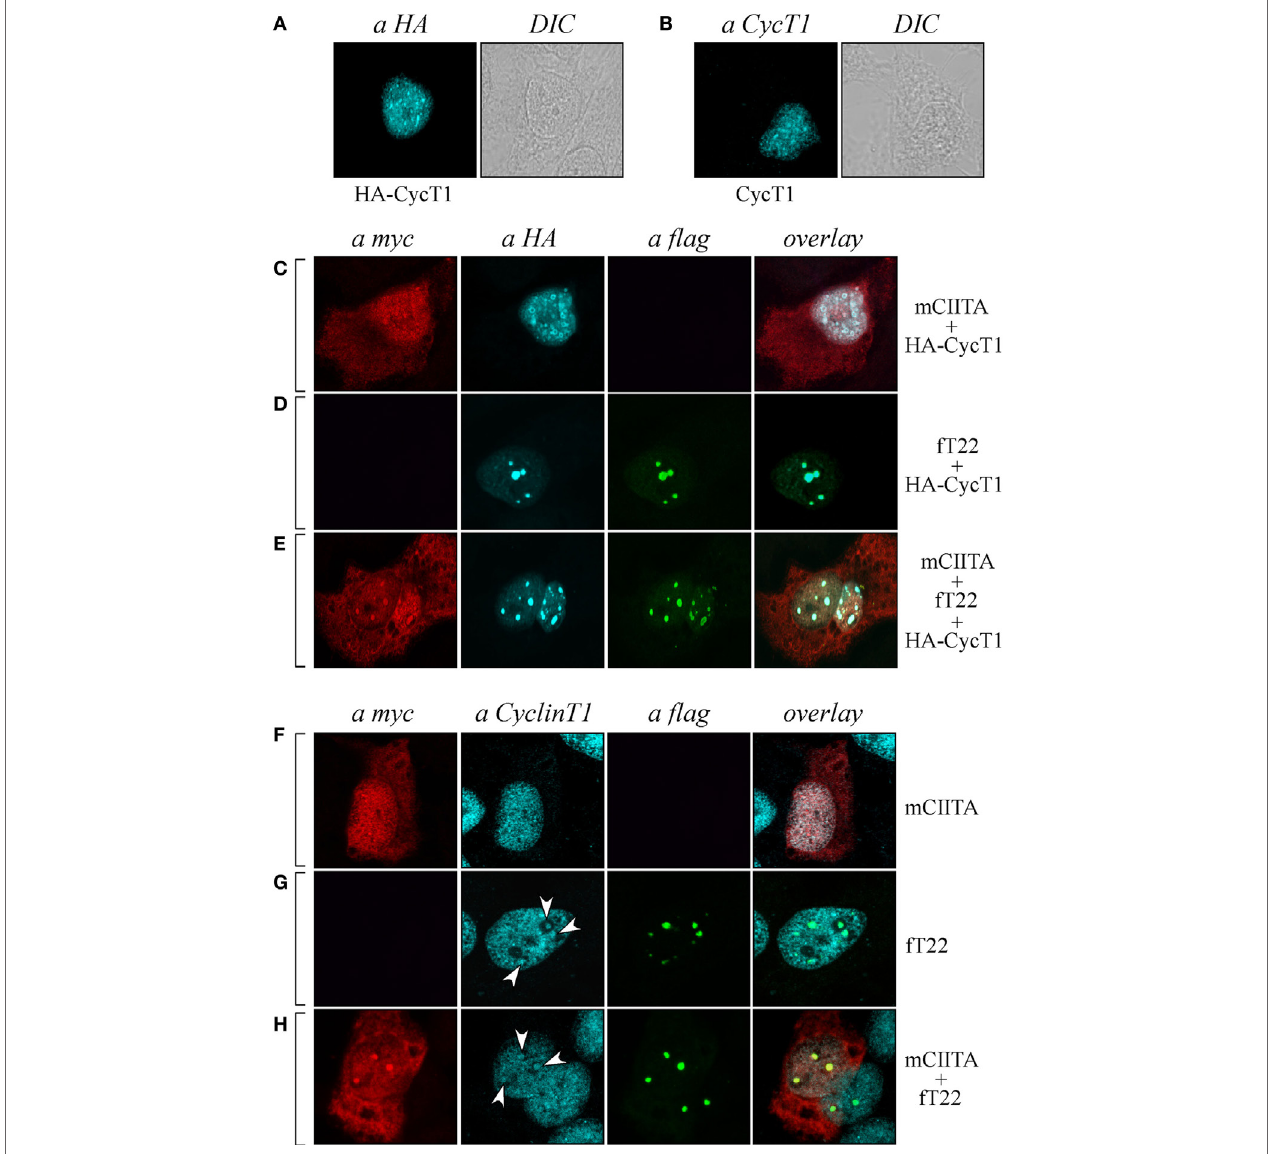
FigUre 6 | Tripartite motif-containing protein 22 (TriM22) recruits both class ii transactivator (ciiTa) and cyclin T1 in nuclear bodies . (a) The expression of hemagglutinin (HA)-tagged Cyclin T1 (HA-CycT1) or (B) endogenous Cyclin T1 was assessed in Hep-2 cells incubated with a mouse monoclonal anti-HA antibody followed by a goat anti-mouse AlexaFluor 633-conjugated antibody or with a rabbit polyclonal anti-Cyclin T1 antibody followed by goat anti-rabbit AlexaFluor 546-conjugated antibody, respectively, and analyzed by immunofluorescence and confocal microscopy analysis. DIC images are shown (right squares). (c,D,e) Hep-2 cells were transfected with mCIITA, HA-CycT1, and TRIM22 (fT22) expression vectors in different combinations, as indicated on the right, and incubated with the antibodies listed on the top. Anti-myc and anti-HA staining was detected with goat anti-rabbit AlexaFluor 546-conjugated and goat anti-mouse AlexaFluor 633-conjugated antibodies, respectively. Flag-TRIM22 was detected by direct staining with fluorescein isothiocyanate-conjugated anti-flag antibody. (F,g,h) Hep-2 cells were transfected with mCIITA and TRIM22 (fT22) expression vectors in different combinations. Anti-myc and anti-Cyclin T1 staining were detected with goat anti-mouse AlexaFluor 633-conjugated and goat-anti-rabbit AlexaFluor 546-conjugated antibodies, respectively. Flag-TRIM22 was detected as in (D,e)